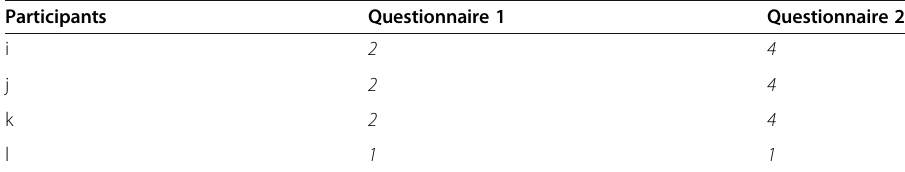
Table 10 Results of questionnaires 1 and 2 Participants